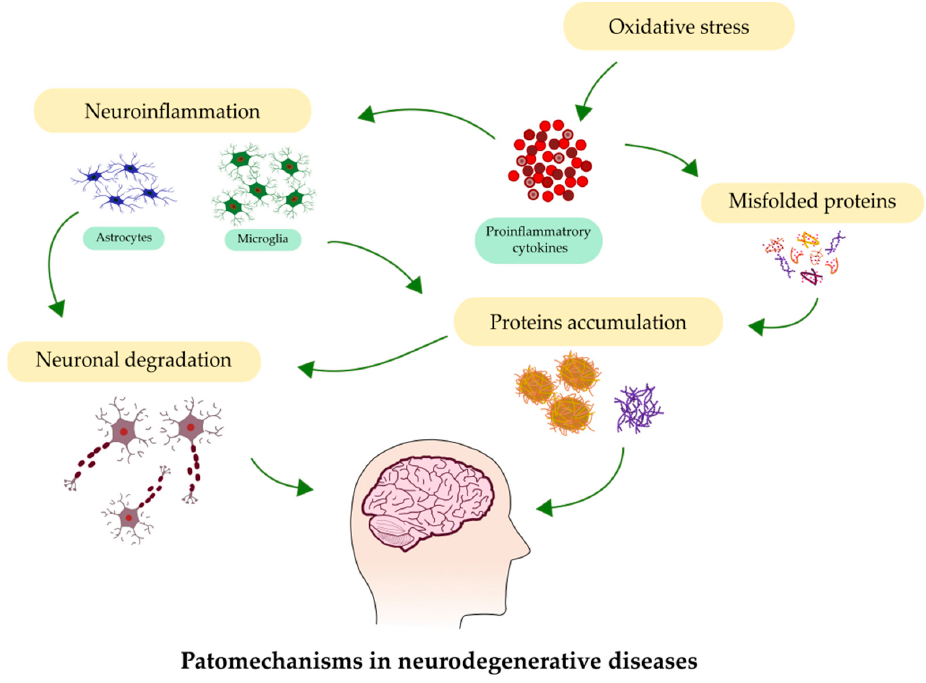
Figure 1. Most common processes involved in the pathology of neurodegenerative diseases.